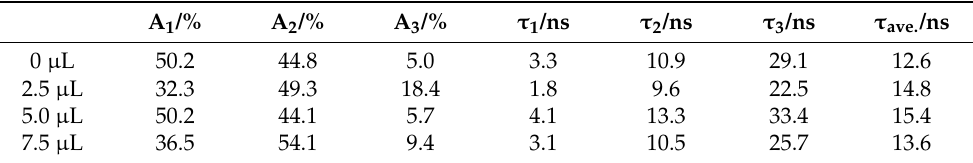
Table 2. PL decay time constant, a short-lifetime, and a long lifetime of MAPbBr 3 PeQDs prepared without water (0 µ L) and with water (2.5–7.5 µ L). A 1 /%